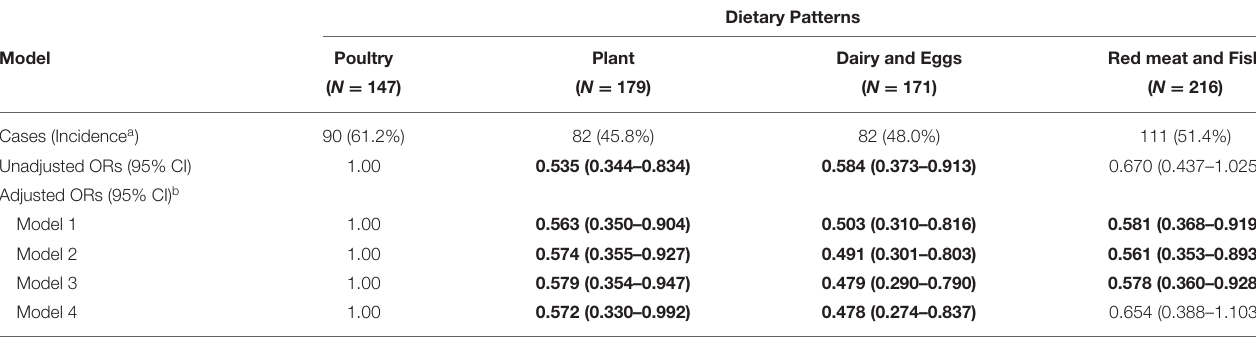
TABLE 3 | Association between maternal dietary protein patterns and infant eczema.